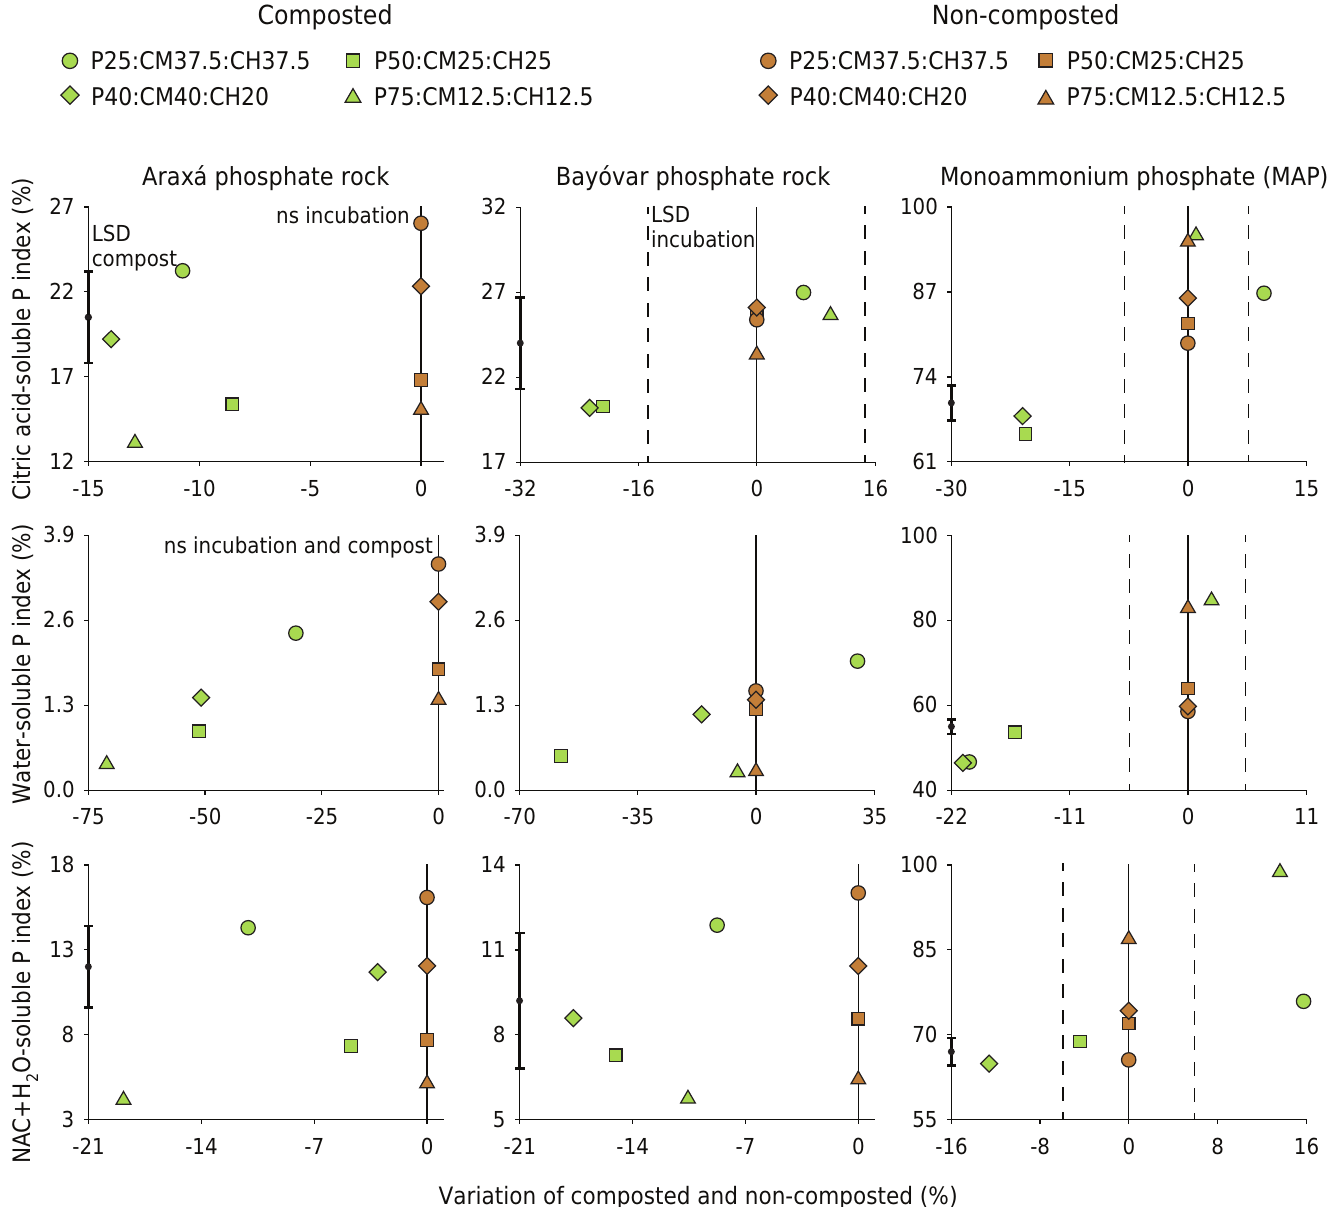
Figure 4. Indexes of soluble P in citric acid, in water, and in neutral ammonium citrate plus water (NAC+H 2 O) of each composted mixture (150 days of incubation) and non-composted mixture (without incubation) for different proportions of chicken manure (CM), coffee husk (CH), and Araxá phosphate rock, Bayóvar phosphate rock, or MAP. LSD: Least Significant Difference by the Tukey test (p<0.05) for compost and incubation. ns: not